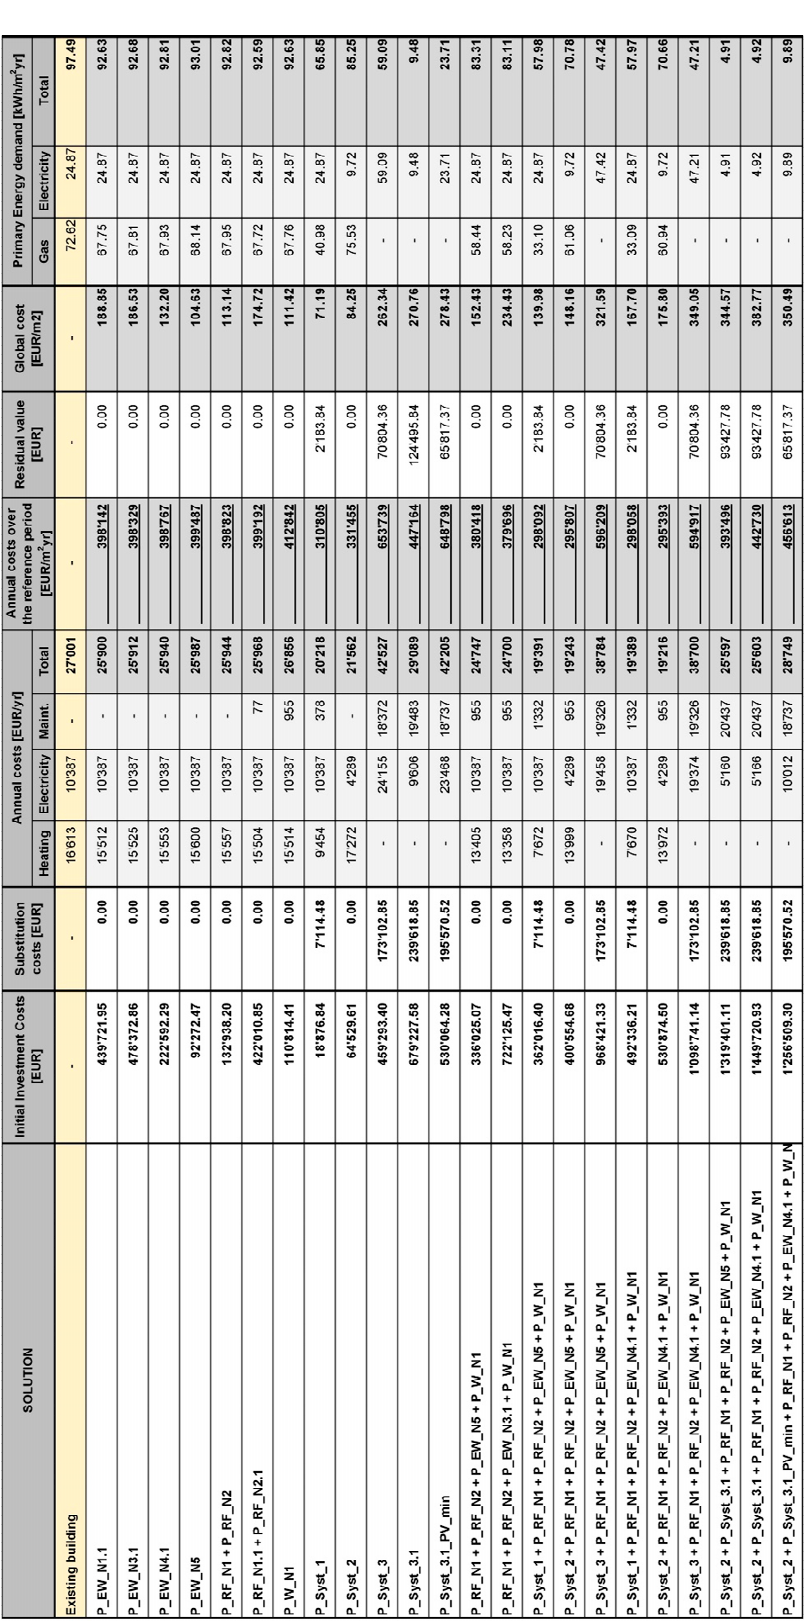
Figure A2. Summary table of cost-optimal methodology for financial scenario with discount rate equal to 5% for Poliziano school.